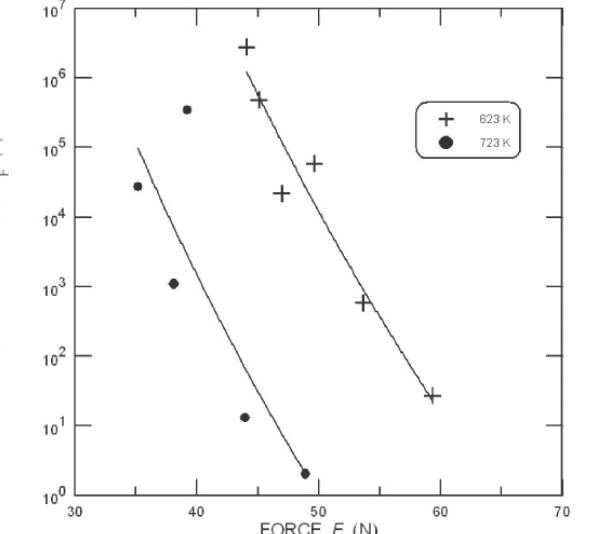
Fig. 17: Dependence of the time to fracture on the applied force